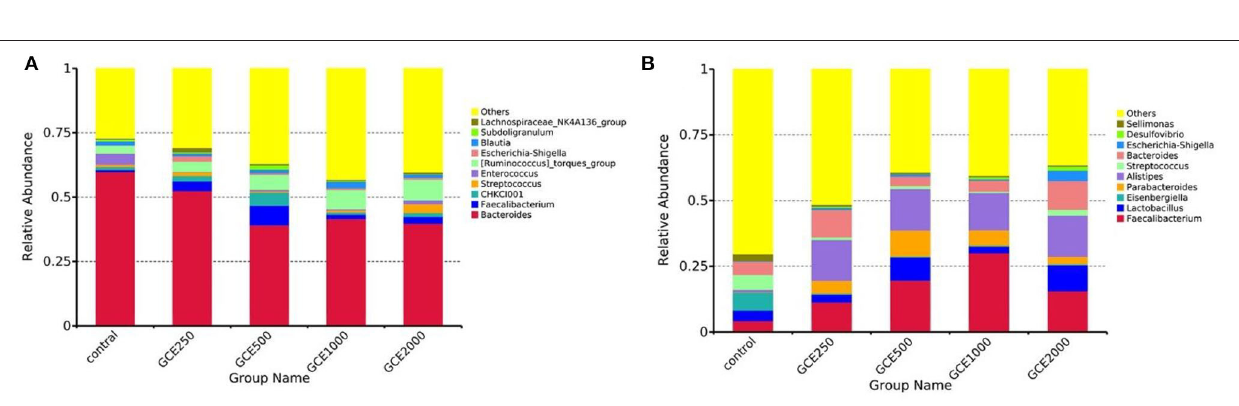
FIGURE 2 | Taxonomic composition of the cecal bacterial communities at genus level in different groups: (A) 28 days; (B) 60 days.